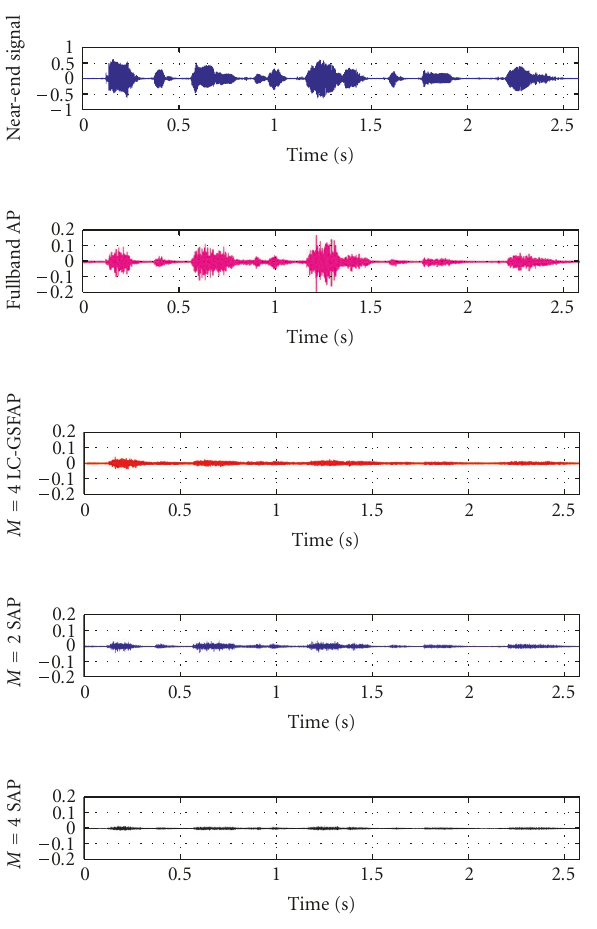
Figure 12: Comparison of residual error signals for Fullband AP, M = 4, OS = 2, and D = 2 LC-GSFAP, M = 2 SAP, and M = 4 SAP with speech as excitation ( N = 512, P = P s = 2, μ = 1, SNR = 30dB).